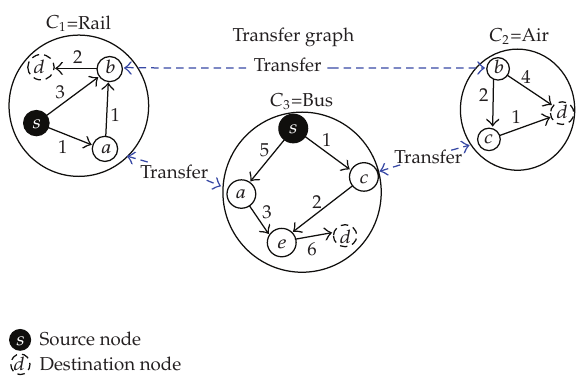
Figure 1: Transfer graph illustrative